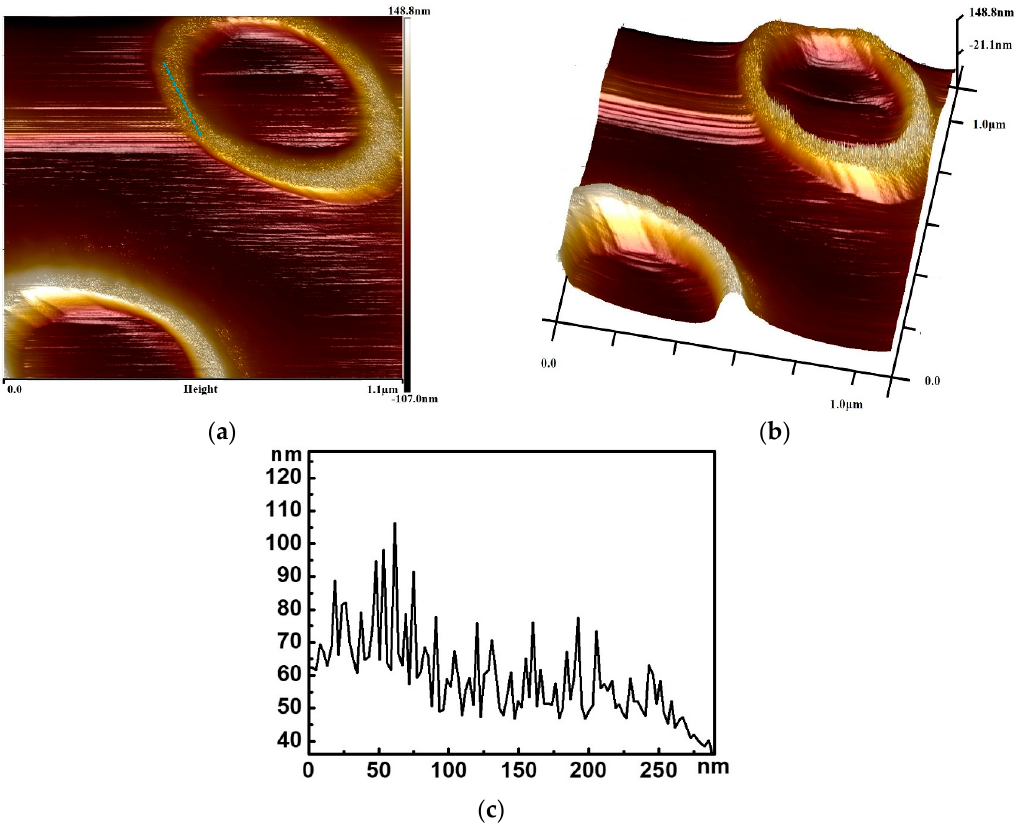
Figure 10. AFM ( a ) 2D and ( b ) 3D images of diatomite and albite treated with 2.38 × 10 − 4 mol/L DDA at pH 5.5, and ( c ) thickness of adsorbed DDA layer on the surface of diatomite.